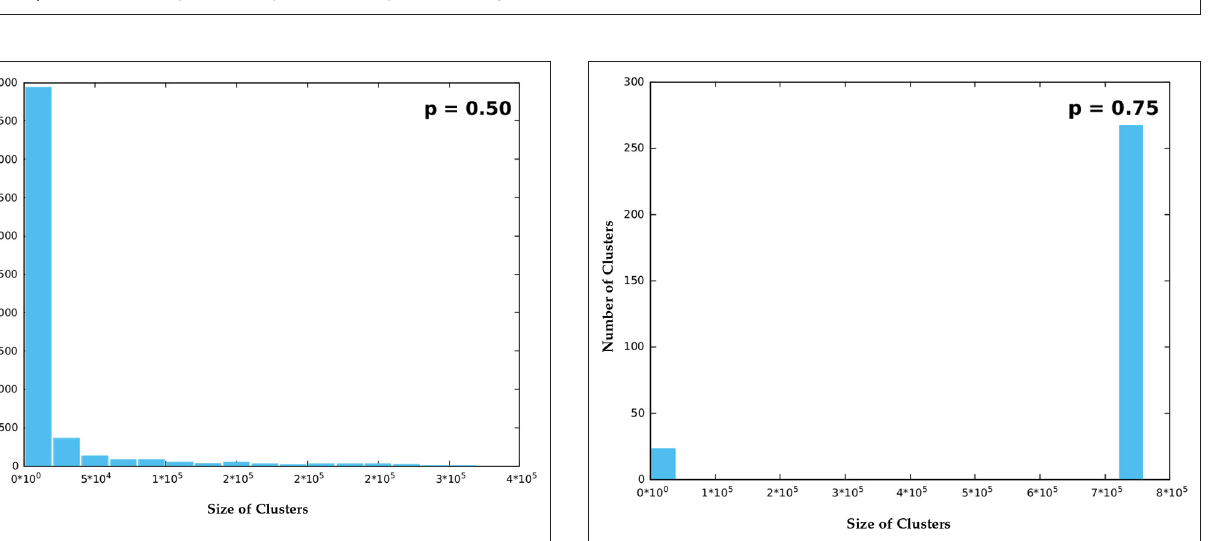
FIGURE 7 | In the sub-critical phase when p = 0.25 an exponential decay is observed.